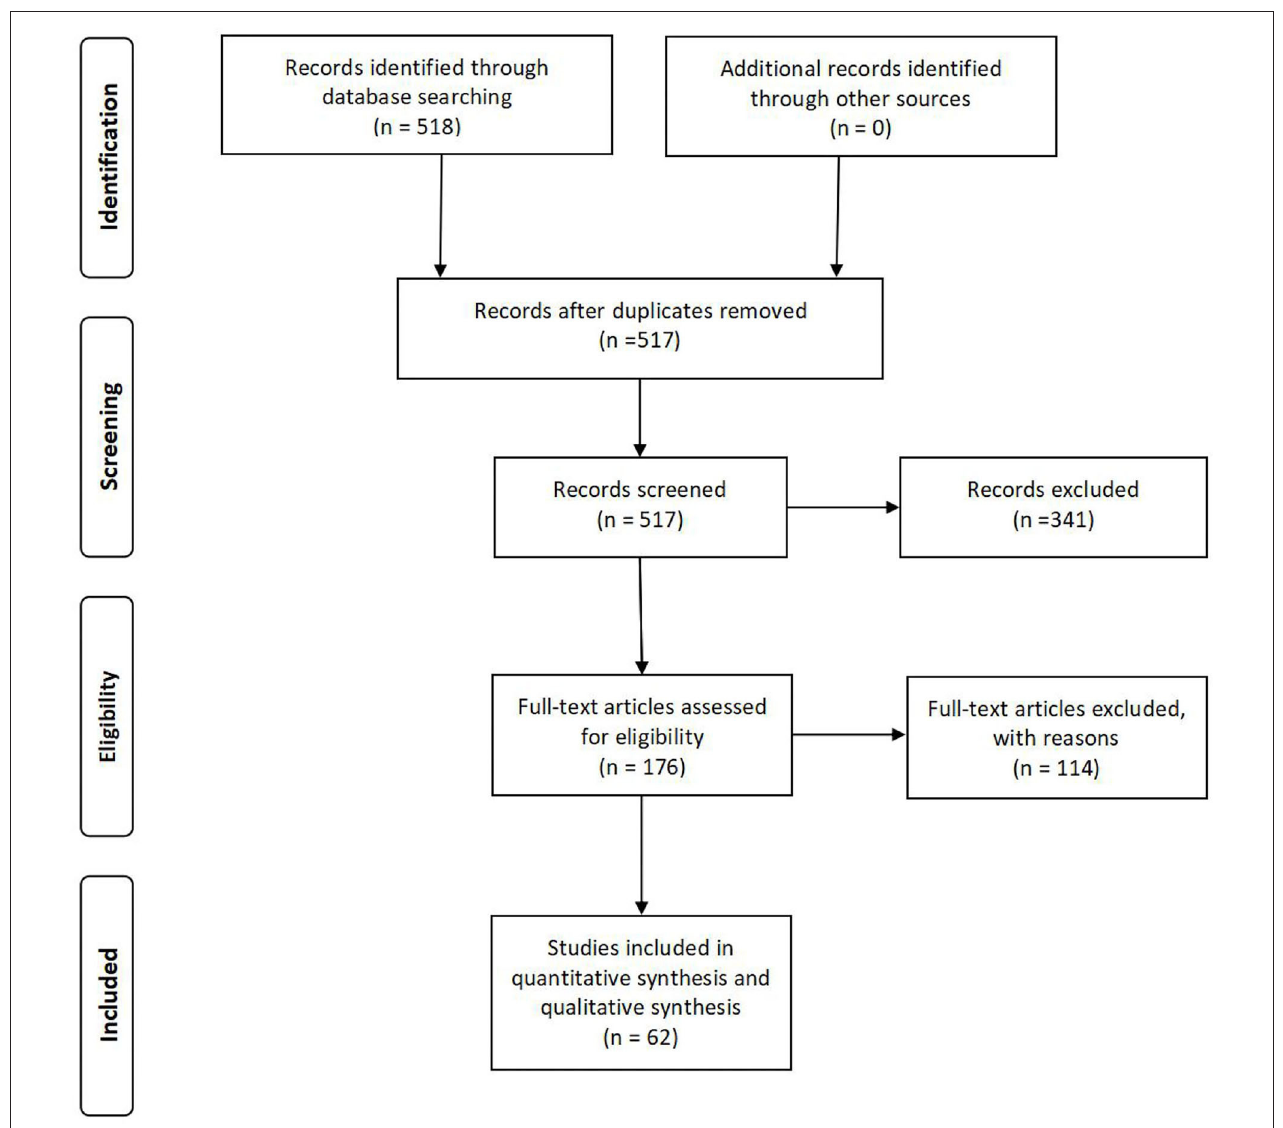
FIGURE 1 | A prisma flow diagram for literature